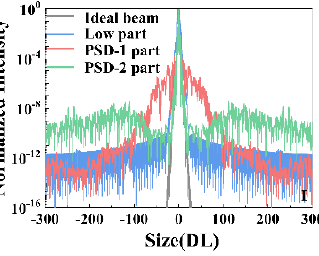
Figure 9. Focal spot intensity of different filtered parts of wavefront I when unfiltered wavefront